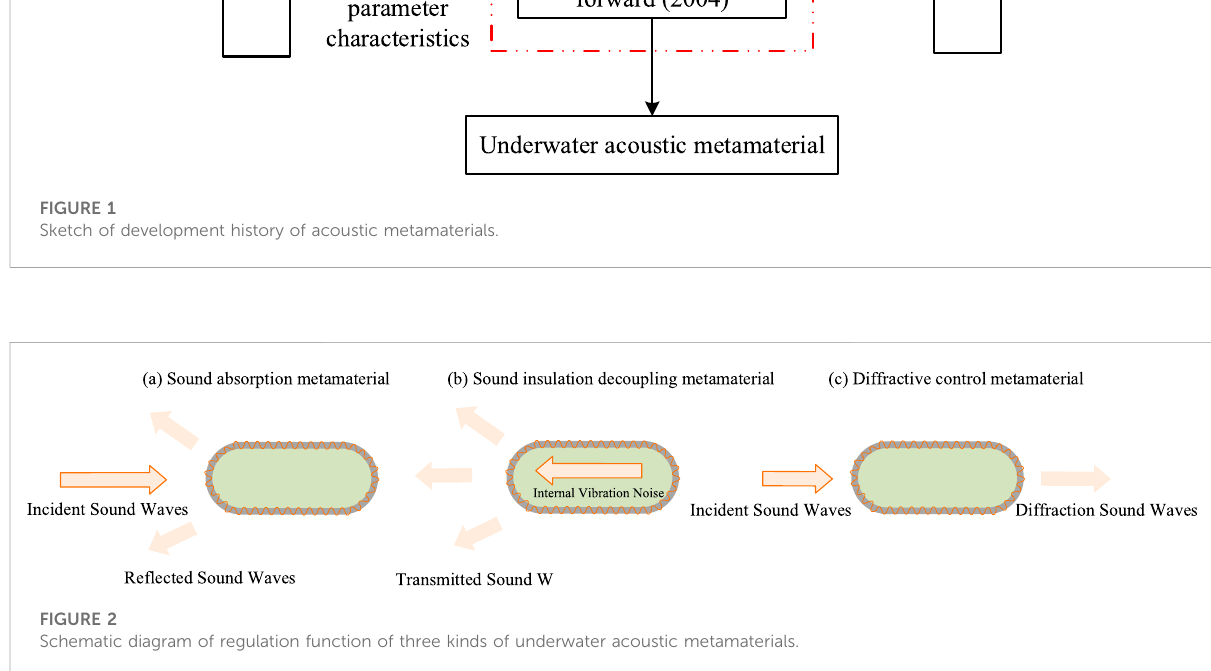
According to different sound absorption mechanisms, SAM